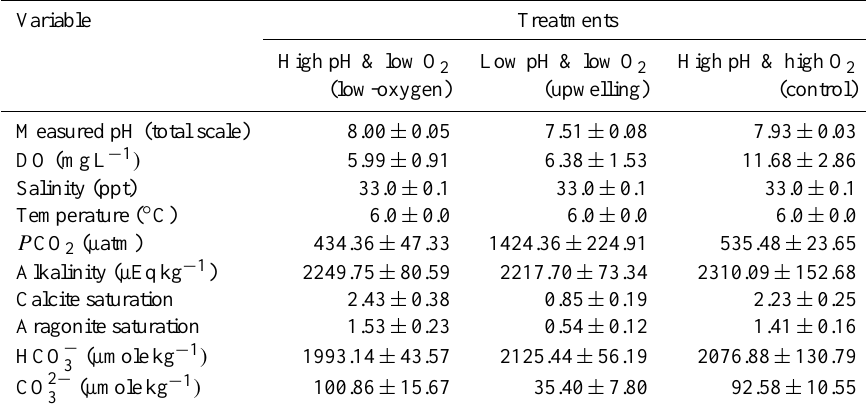
Table 1. Carbonate system and other physical parameters for experimental treatments measuring the response of juvenile abalone to up- welling conditions (mean ±